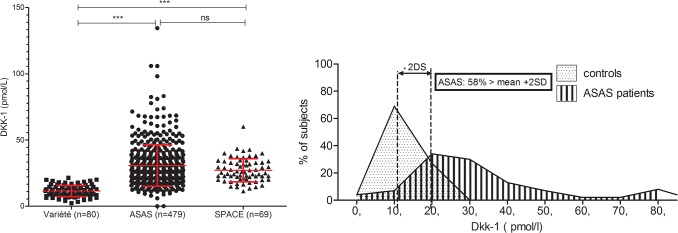
(A) Serum DKK-1 level among axial SpA patients and controls at baseline. Each point represents 1 patient. Data are mean ± SD. *** p< 0.0001. (B) Distribution of DKK-1 levels in controls and axial SpA patients.